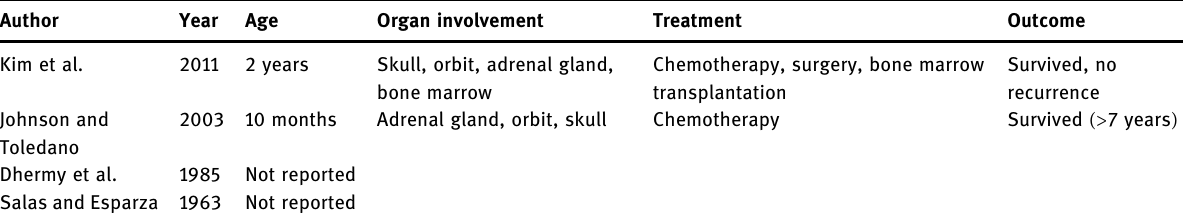
Table 1: Comparison of published cases of orbital ganglioneuroblastoma